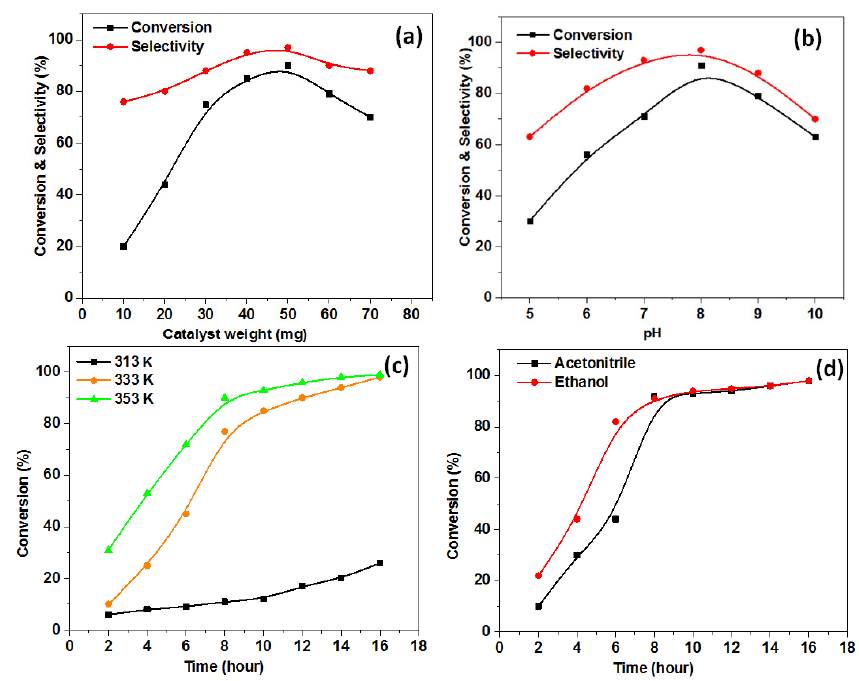
Figure 5. Optimum reaction conditions of the catalytic epoxidation of cyclohexene using 10% Ni@CSs composite: ( a ) effect of catalyst dose (353 K, pH = 8, and 14 h); ( b ) effect of pH (50 mg catalyst, 353 K, and 14 h); ( c ) effect of temperature (50 mg catalyst, pH = 8, and 14 h); and ( d ) effect of solvent (50 mg catalyst, 353 K, pH = 8).